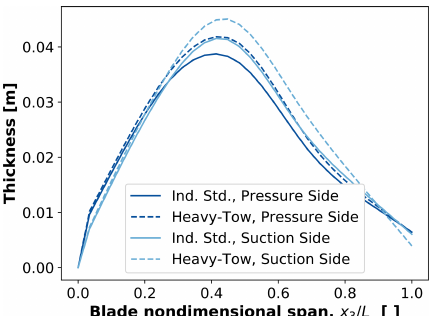
Figure 14. Comparison of optimized spar cap thickness distribu- tion for the BAR-DRC design using industry-standard carbon fiber unidirectional composite and heavy-tow fiber composite.